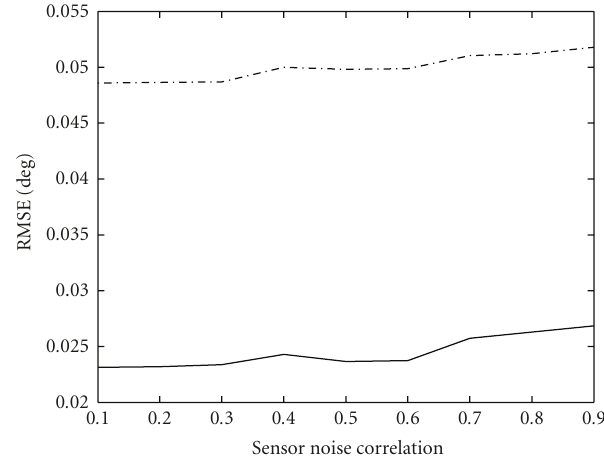
Figure 3: RMSE versus sensor noise correlation: proposed method (solid) and MUSIC method in [16]